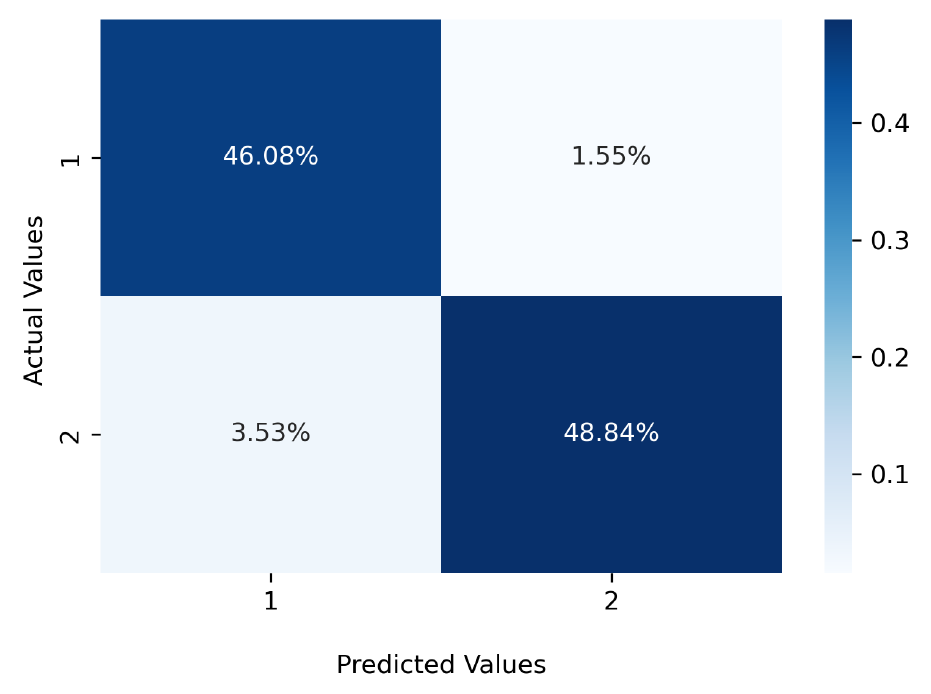
Figure 10. Confusion matrix for the RF algorithm for detecting LB deviations greater than 0.9 mm. Photos from of the top and root view of a weld seam with controlled LB deviation from − 2.5 mm to 2.5 mm is presented in Figure 11 showing typical lack of fusion defects caused by a LB offset. Lack of fusion caused by the LB deviation is marked with red in the root view of the welded